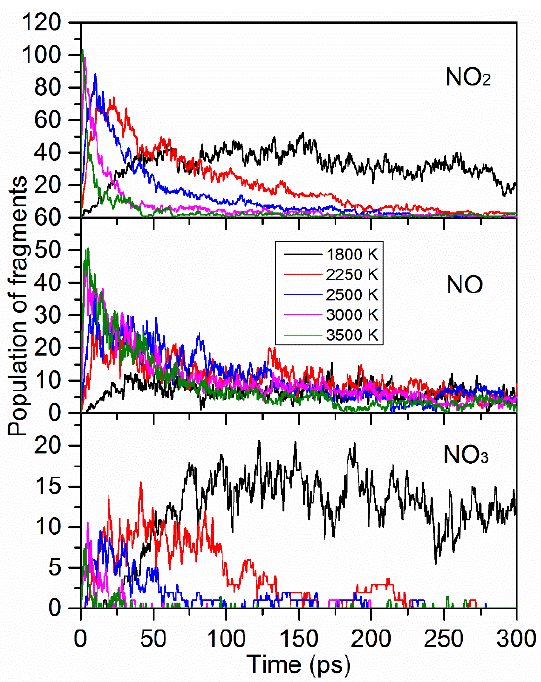
Figure 8. Time evolution of the main fragments NO 2 , NO, and NO 3 during the whole decomposition stage at the five extreme conditions. The thick trendlines correspond to the actual concentration data of the matching color.